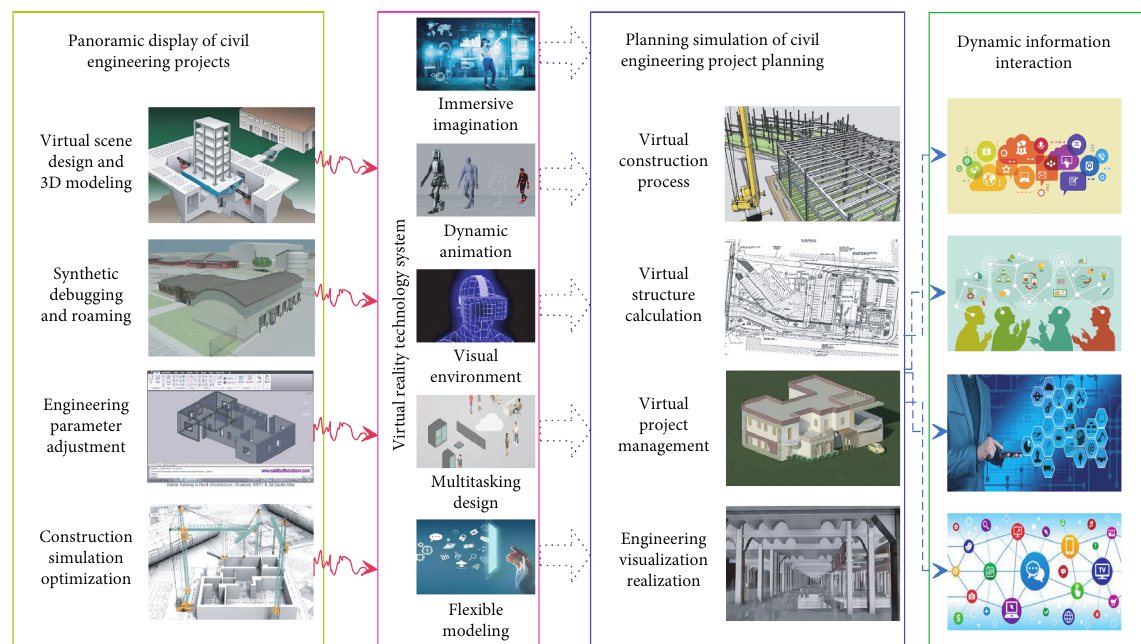
Figure 1: Virtual scene design and three-dimensional modeling of civil engineering project based on virtual reality